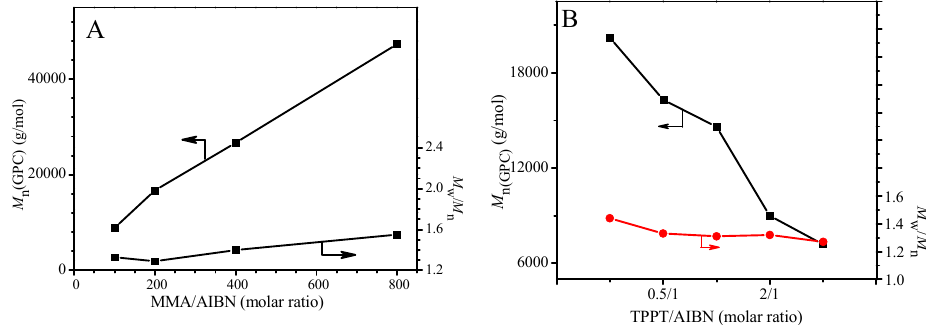
Figure 2. Influences of MMA/AIBN ( A ) and TPPT/AIBN ( B ) ratios on the molecular weight and M w / M n of the polymers obtained from the polymerization with feed molar ratios of TPPT/AIBN = 2/1 ( A ) and MMA/AIBN = 100/1 ( B ) in anisole at 70 °C for 12 h. (Monomer content: 50 wt %). The results in Figure 2 demonstrate that the main factors influencing chain length of the formed polymer are the concentrations of AIBN and TPPT in the monomer and their ratio. To better